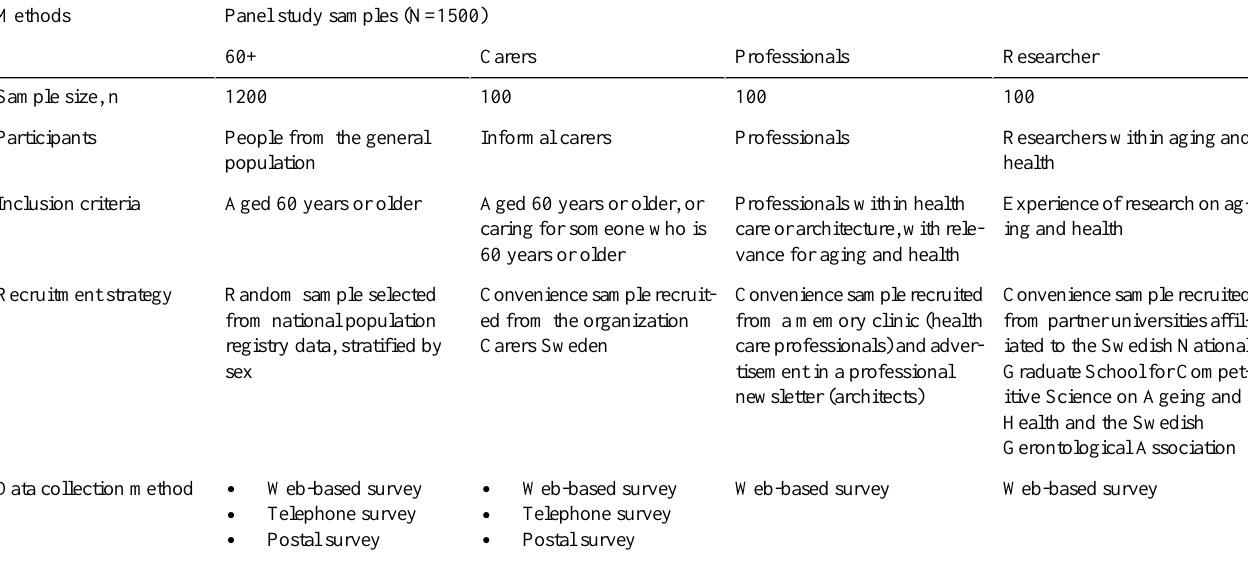
Table 1. Overview of study samples, inclusion criteria, recruitment, and data collection methods. Panel study samples